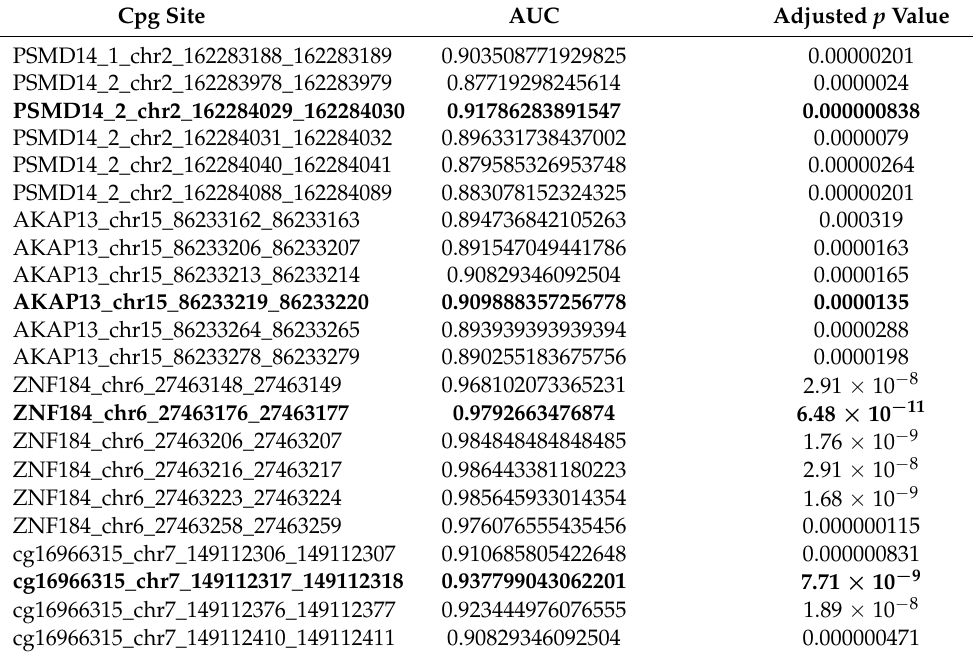
Figure 2. The heatmap of different methylation regions in cohort 1. The parameter “condition” represents the benign controls in blue and the UBC tumor samples in red. Table 2. AUC values of the top 6 methylation regions of different biomarkers.